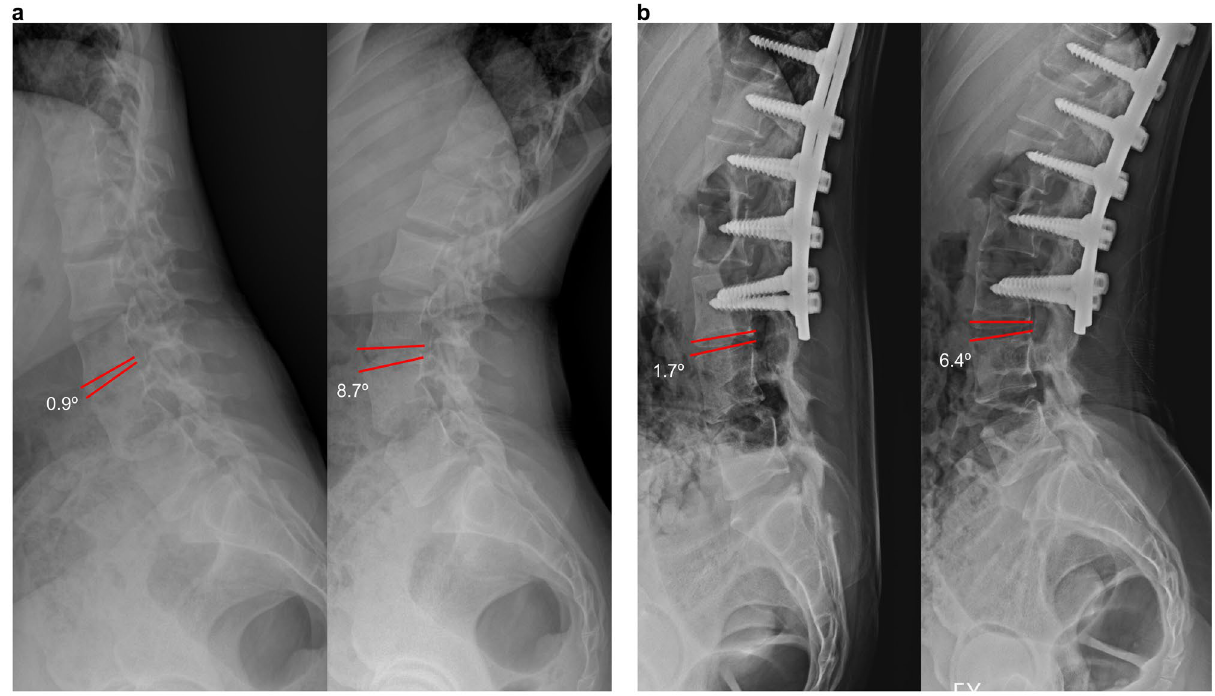
Figure 4. L3/4 lateral disc mobility in full flexion–extension dynamogram of the same patient shown in Fig. 3–1. ( a )The preoperative L3/4 lateral disc mobility is 7.8°. ( b ) The L3/4 lateral disc mobility of 4.7° at the last follow-up, after the second surgery.